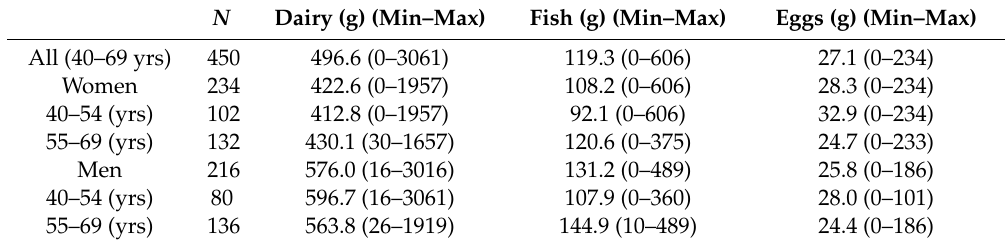
Table 4. Estimated mean intake of dairy products, fish, and eggs among men and women aged